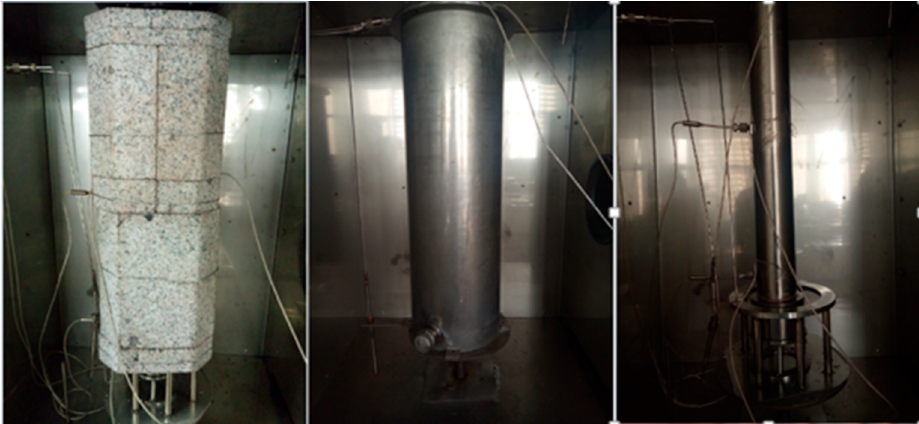
Figure 2. The heat exchange tube with granite jacket, quartz sand cylinder or air ambient (from left to right). The thermal properties of various fluids, heat storage media as well as the heat exchange tube and the sand cylinder are listed in Table 1, which would be used in the experimental result analysis. Table 1. Thermal properties of fluids, heat storage media and stainless-steel tube at 0.1 MPa and 20 ◦ C. Water as Heat Quartz Cylinder Heat Heat Air in the Transfer Oil Sand Filled Granite Property Used for Exchange Transfer Thermotank Filled in the in the Jacket Tube Fluid Tubing Wall Cylinder Filling Sand Density, kg / m 3 998.2 7930 7930 Specific heat capacity, 4182 1621.8 500 500 J / (kg · K) Thermal conductivity, 0.62 W / (m · K)